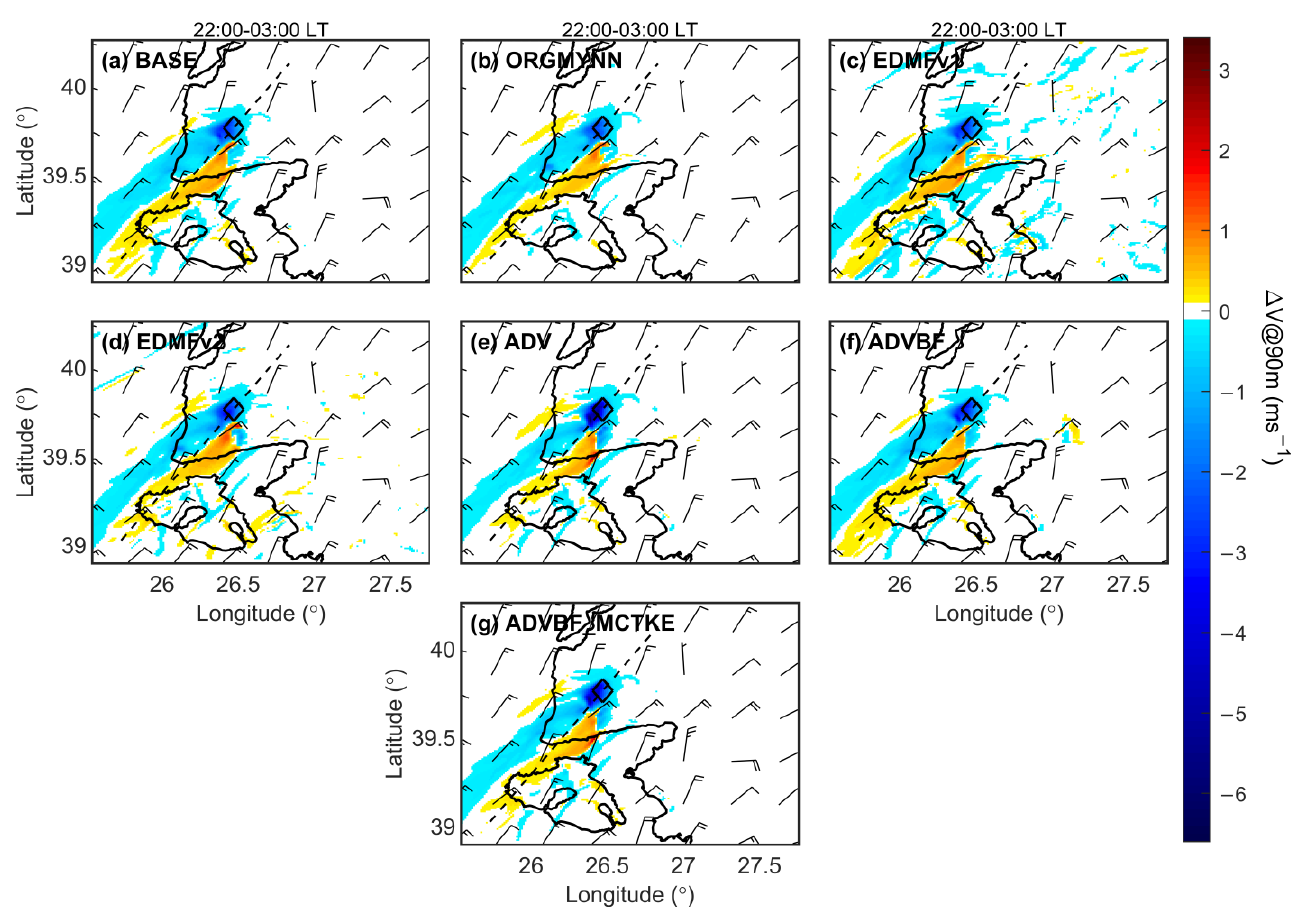
Figure 8. Wind farm wake impact on TKE from a vertical cross-section for the simulations of ( a – g ) BASE, ORGMYNN, EDMFv1,EDMFv2, ADV, ADVBF and ADVBF_MCTKE . Box represents the rotor area of the wind farm. The dashed horizontal line represents the hub height of the wind tur- bine.